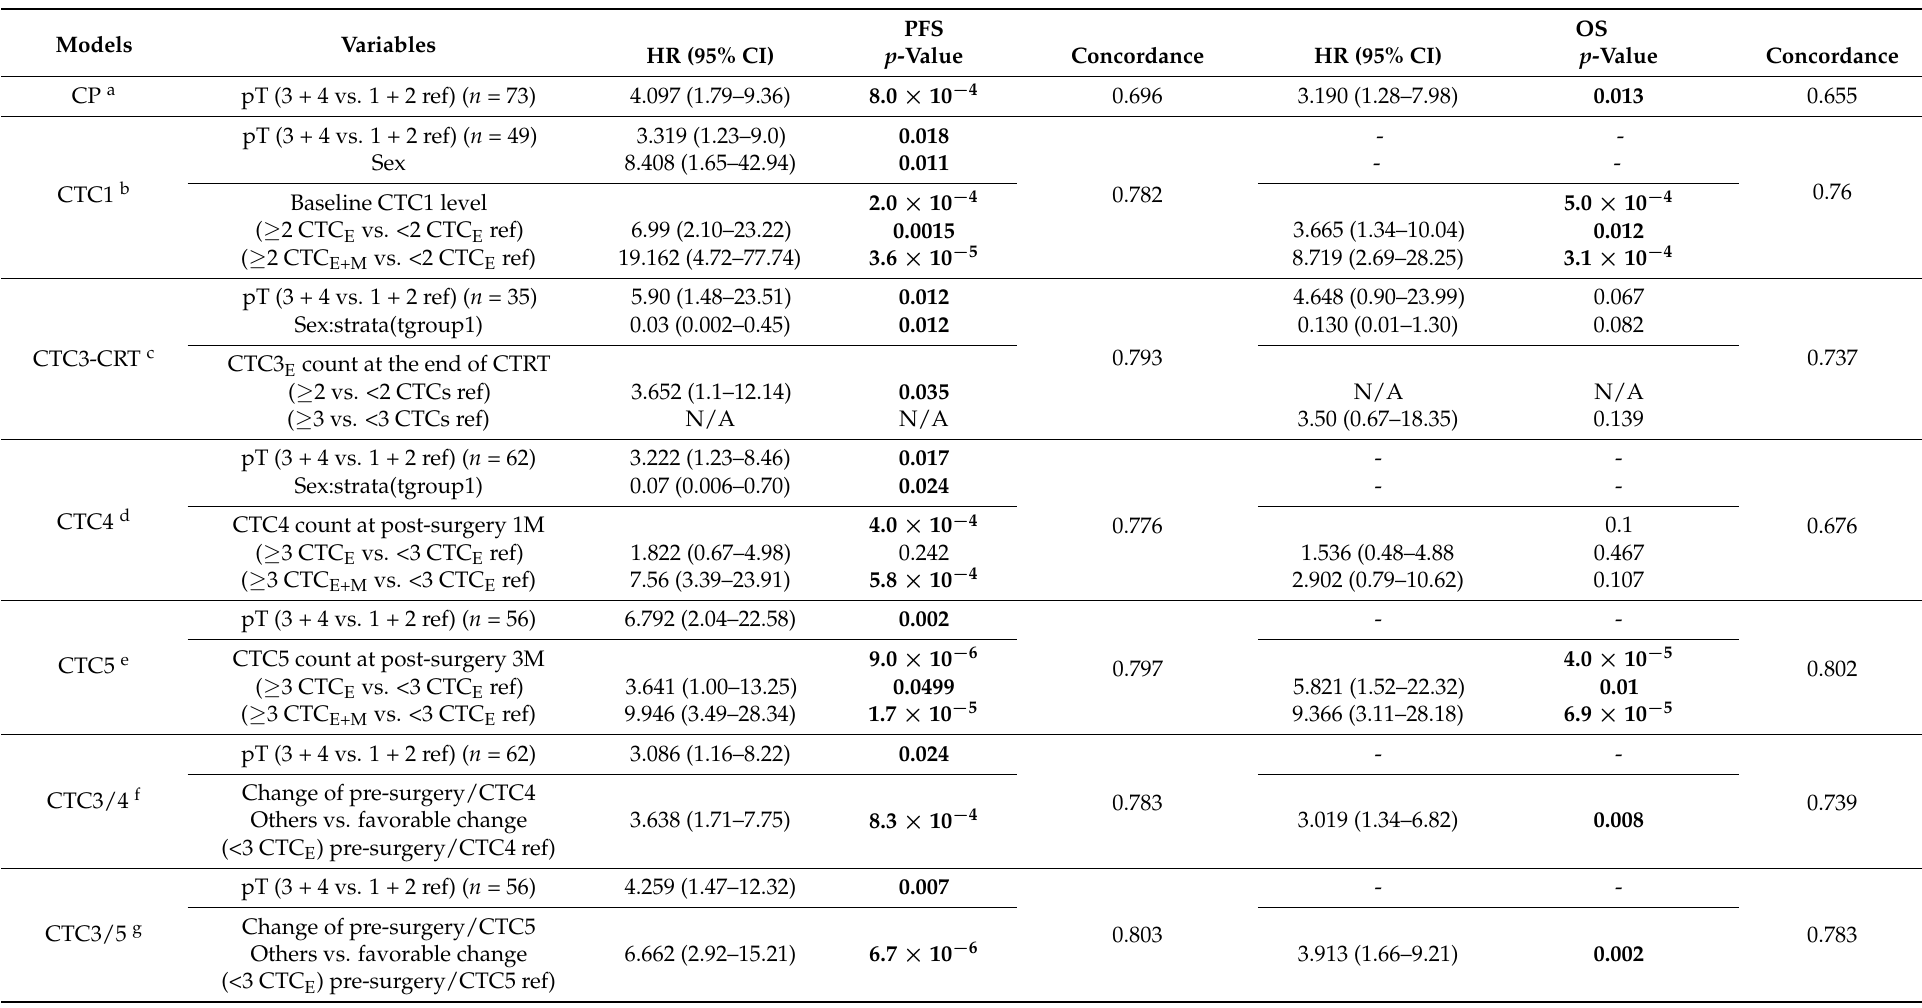
Table 2. Multivariate COX regression analysis of clinical pathological (CP) parameters and CTC counts at baseline, pre- and post-operation with progression-free and overall